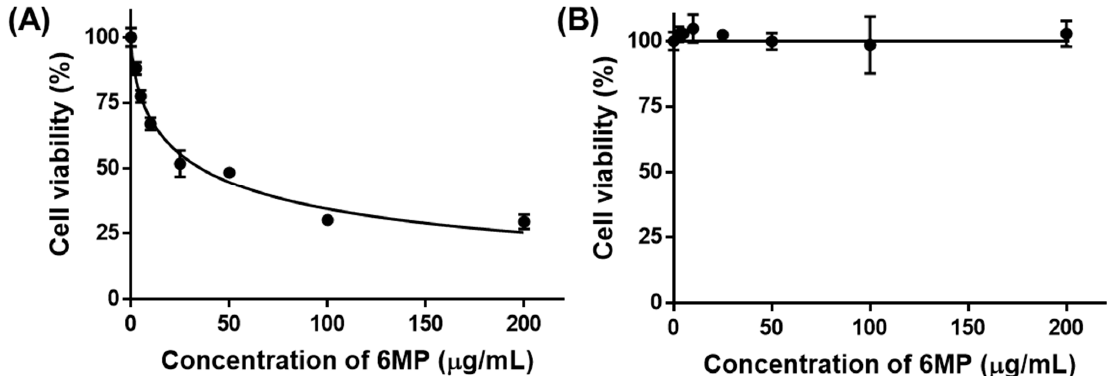
Figure 3. Viability of ( A ) HCT-116 cells and ( B ) fibroblasts after treatment with different concentra- tions of 6-MP.